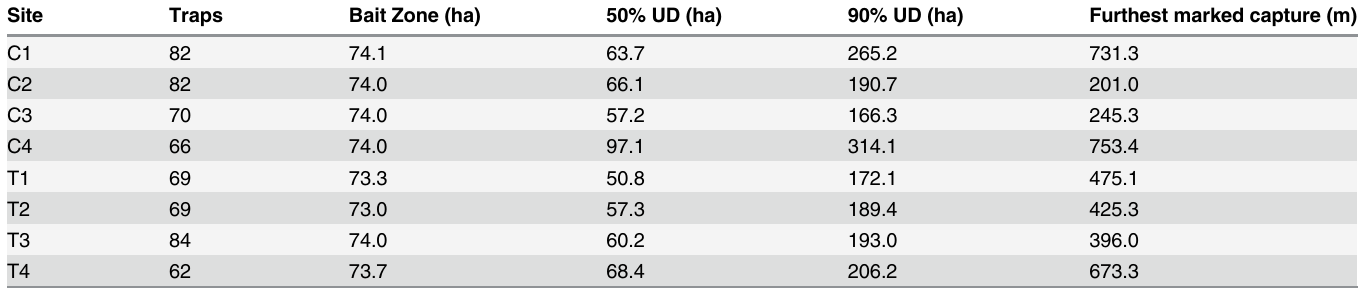
Table 4. Number of traps placed, size of the area in which Rhodamine B baits were placed, 50% and 90% kernel utilization density (UD) areas of raccoon recaptures exhibiting Rhodamine B marks, and the distance from the center of the trapping web of the trap in which the furthest RB marked recapture occurred on 8 study sites in the Upper Wabash River Basin,